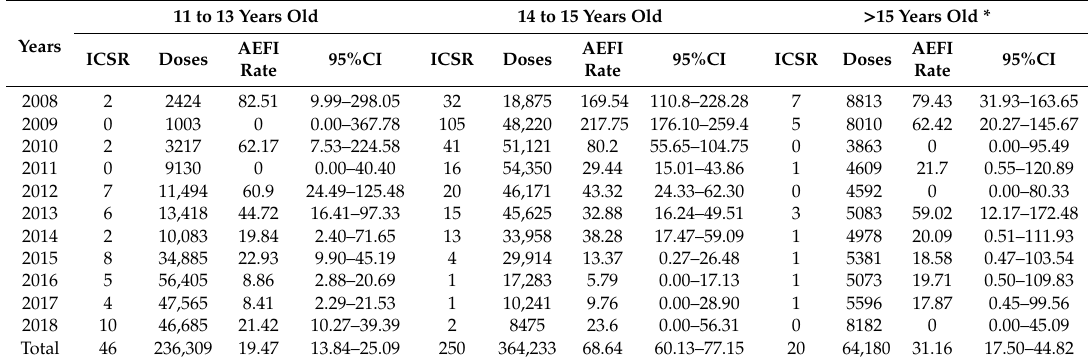
Table A1. Trends in AEFI reporting rate following HPV immunizations in the Valencian Community, Spain according to age